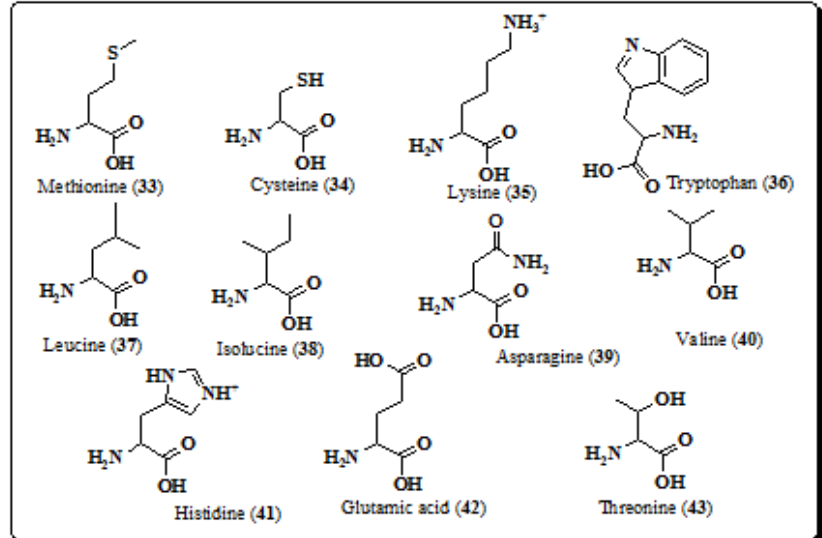
Figure 5. Structures of amino acids from E. laevis. ( 33 – 43 ).